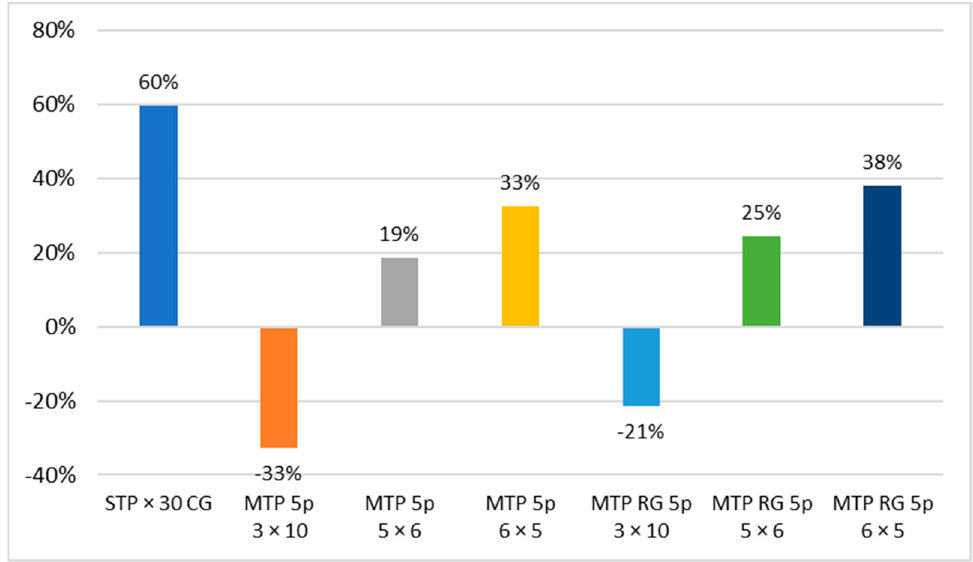
Figure 12. The comparison of power savings per task relative to the architecture consisting of single-task cores (STP) for different structures with SP = 150.